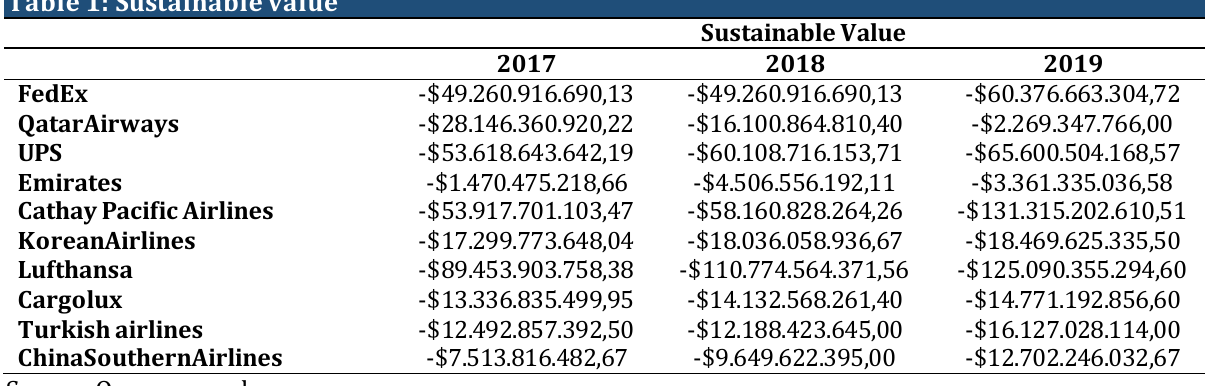
Table 1: Sustainable